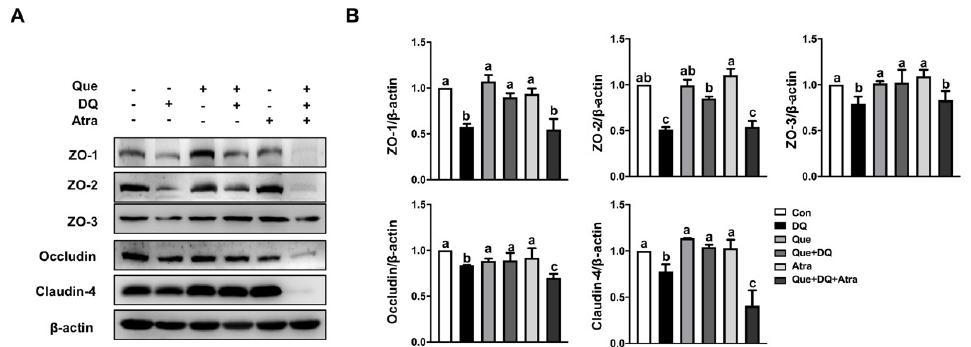
Figure 7. Quercetin regulated the abundance of tight junction proteins in a Nrf2-dependent manner. IPEC-1 cells were treated as described in Figure 5. ( A , B ) Protein abundance for ZO-1, ZO-2, ZO-3, occludin, and claudin-4 were assessed. Representative experimental results were repeated in three independent experiments and values are means ± SEMs, n = 3. Means without a common letter are considered as a significant difference, p <